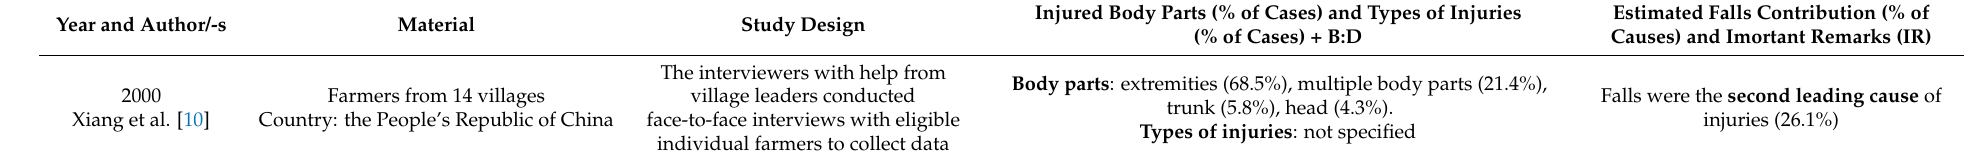
Table 1. Burden of fall-related injuries in various rural